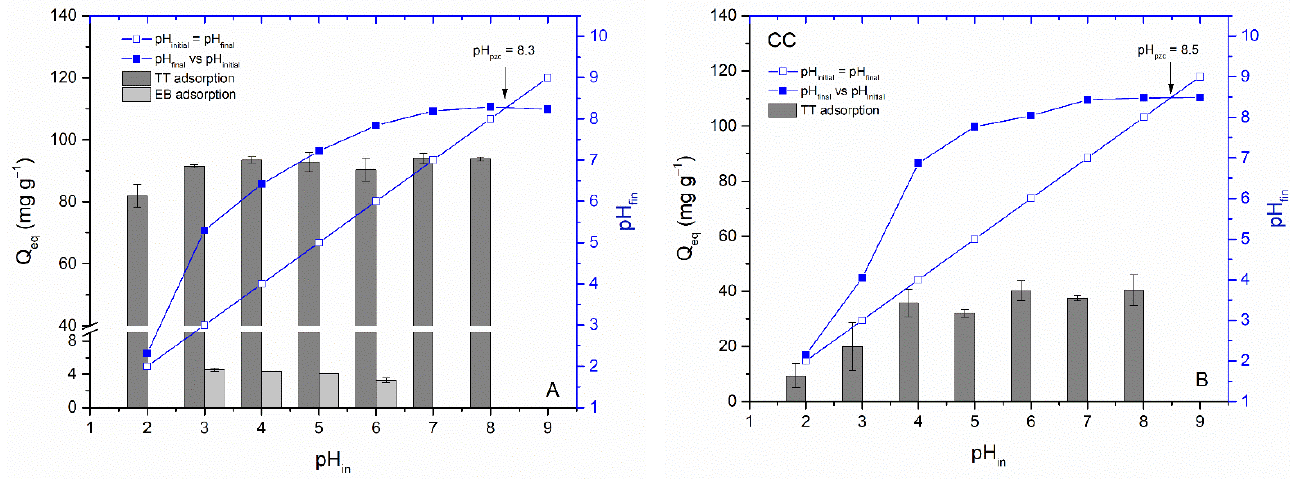
Figure 7. Determination of pH pzc and the influence of pH in on TT (100 mg L − 1 ) adsorption by WC ( A ) and CC ( B ) and EB (45 mg L − 1 ) adsorption by WC ( A ) biochar (8.3 g L − 1 ; T = 22 °C).